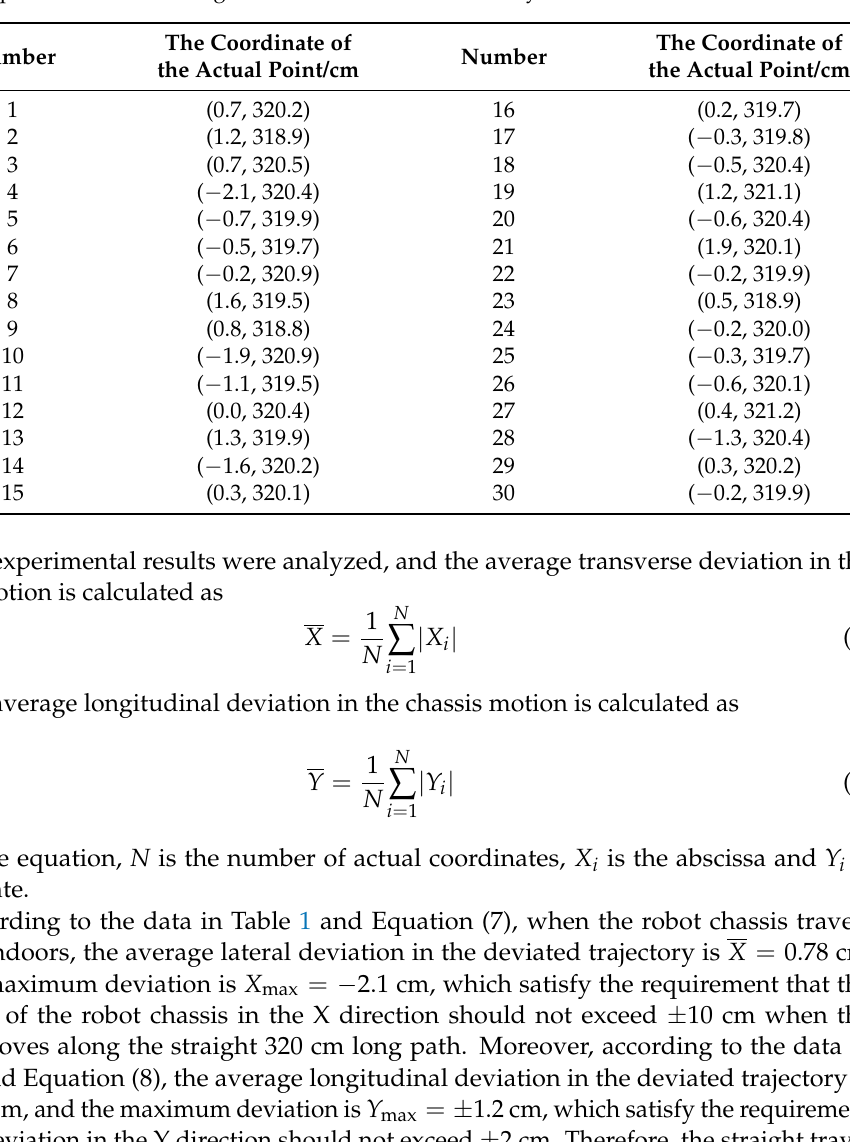
Table 1. Experiment data of straight-line motion in the